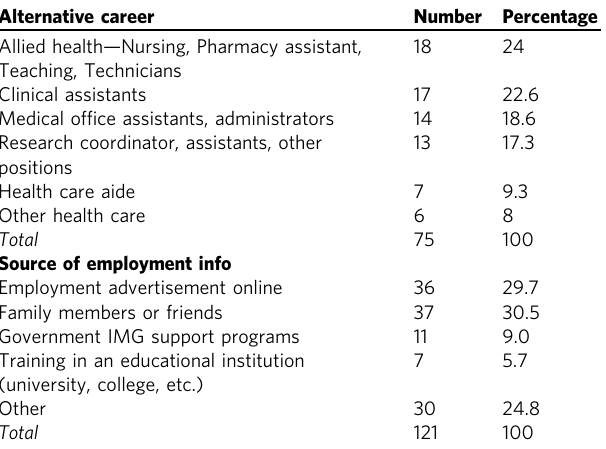
Table 3 Alternate careers in healthcare and sources of alternative